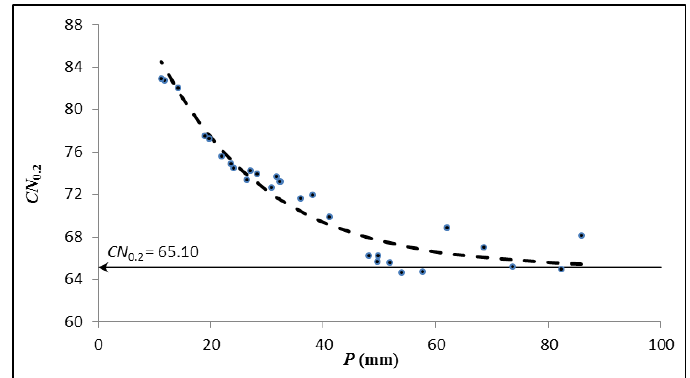
Figure 2. Standard behavior pattern, CN inf = 65 for Wangjiaqiao